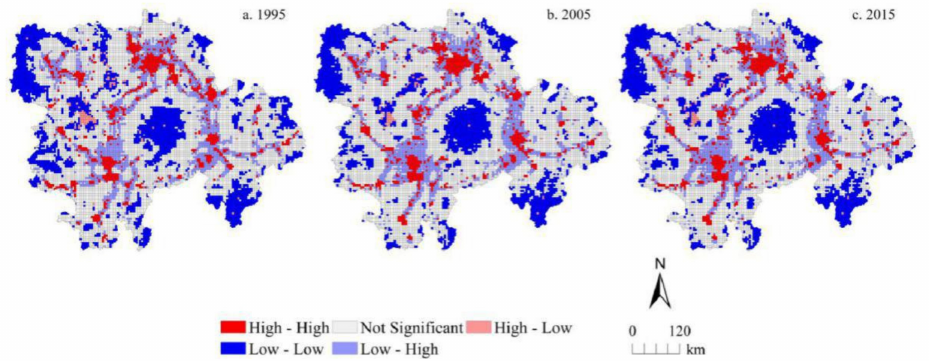
Figure 6. Bivariate LISA cluster maps showing urbanization level and traffic accessibility in the Middle Reaches of the Yangtze River Urban Agglomerations at 5 km gride scale.